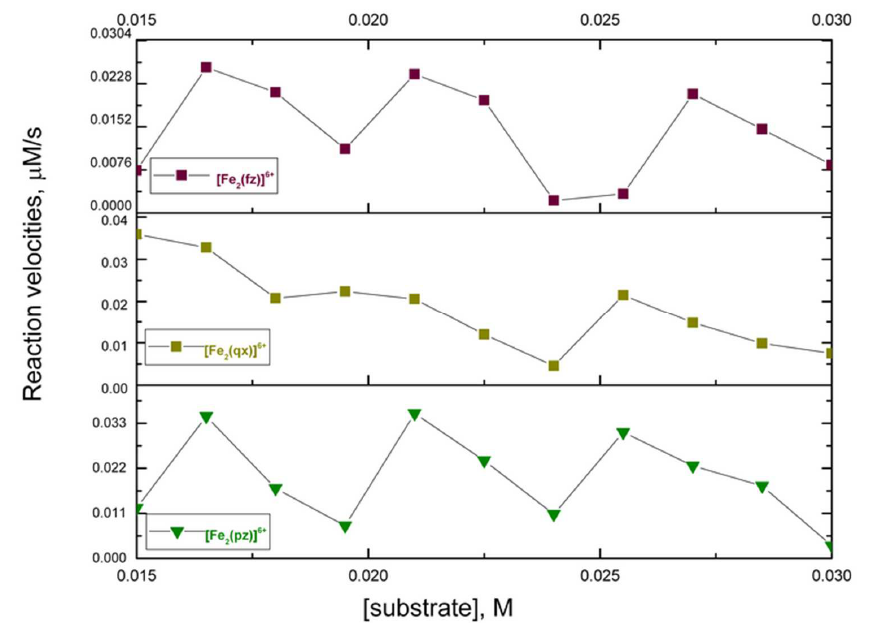
Figure 5. Initial rate results on the oxidation reaction of DTBC to DTBQ and catalyzed by [Fe 2 (pz)] 6+ , [Fe 2 (qx)] 6+ , and [Fe 2 (fz)] 6+ .